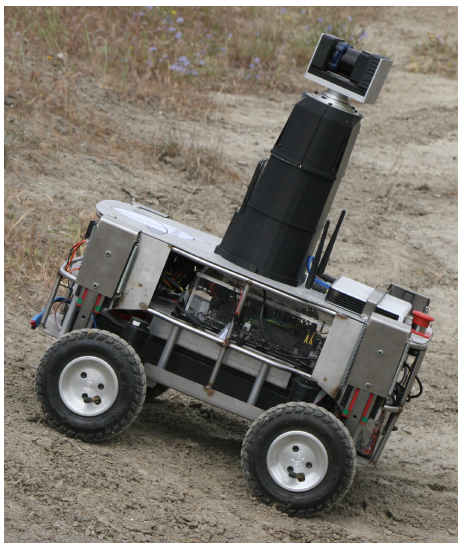
Figure 1. Andabata mobile robot equipped with its 3D laser scanner on the upper